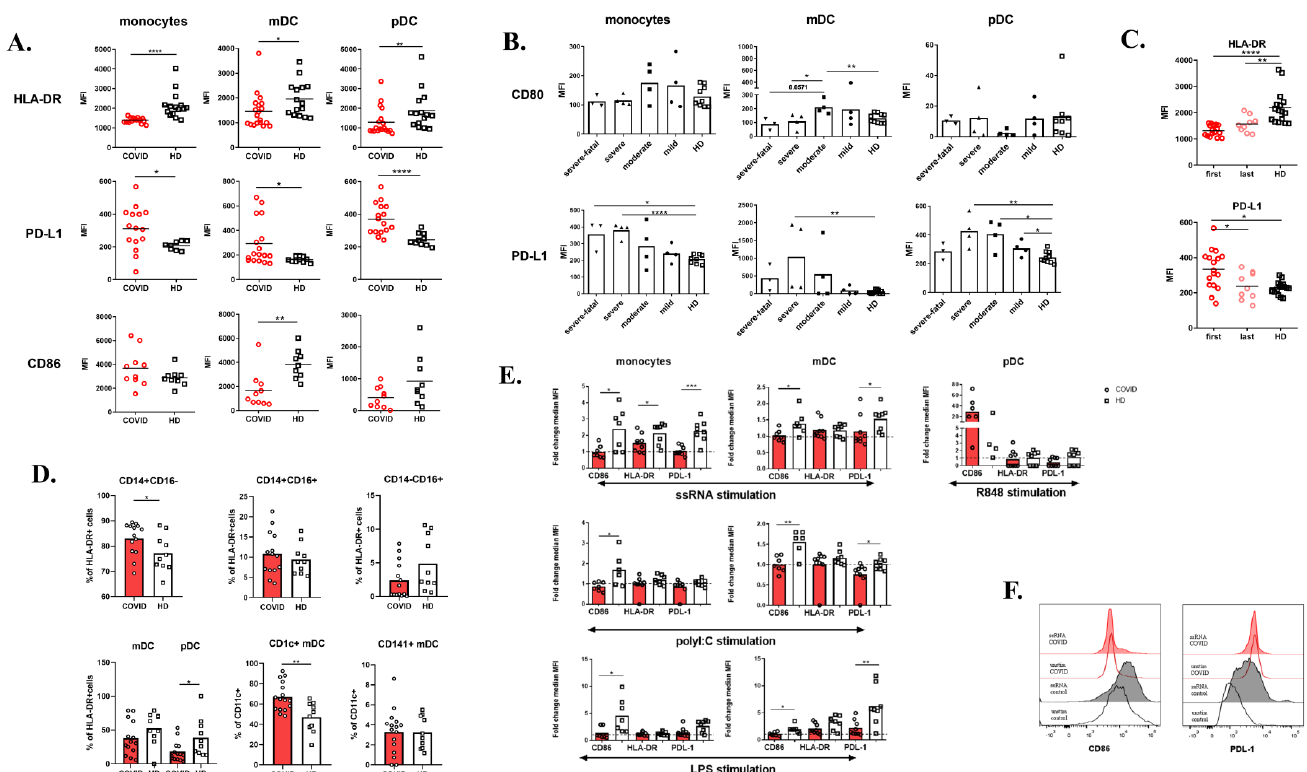
Figure 3. Phenotype of monocytes and dendritic cells. ( A ) HLA-DR, PD-L1, and CD86 expression on monocytes, myeloid, and plasmacytoid dendritic cells (mDCs, pDCs) detected by flow cytometry. Data are expressed as mean fluorescence intensity (MFI). ( B ) CD80 and PD-L1 expression on monocytes, mDCs, and pDCs of COVID-19 ( n = 15) patients divided according to the severity of the disease. Data are expressed as MFI. ( C ) HLA-DR and PD-L1 expression on COVID-19 monocytes detected after admission to the hospital (“first”, n = 17) and after time of 2–4 weeks (“last”, n = 9). Data are expressed as MFI. ( D ) Peripheral blood monocytes and DC subpopulations of COVID-19 patients ( n = 14) and HD ( n = 10) assessed by flow cytometry. ( E ) Whole blood was stimulated with 10 µ g / mL ssRNA, 50 µ g / mL polyI:C, 1 µ g / mL R848, 1 µ g / mL LPS, or left untreated overnight and then CD86, HLA-DR, and PD-L1 expression on the surface of monocytes, mDCs, and pDCs were analyzed. Data are expressed as fold change (stimulated MFI / unstimulated MFI) of nine COVID-19 patients and eight HD. ( F ) Representative histograms of CD86 and PD-L1 expression upon ssRNA stimulation of COVID-19 patients and HD. Statistical analysis was performed using the Wilcoxon paired or Mann–Whitney unpaired t -test. Values of p < 0.05 (*), p < 0.01 (**), p < 0.001 (***), and p < 0.0001 (****) were considered statistically